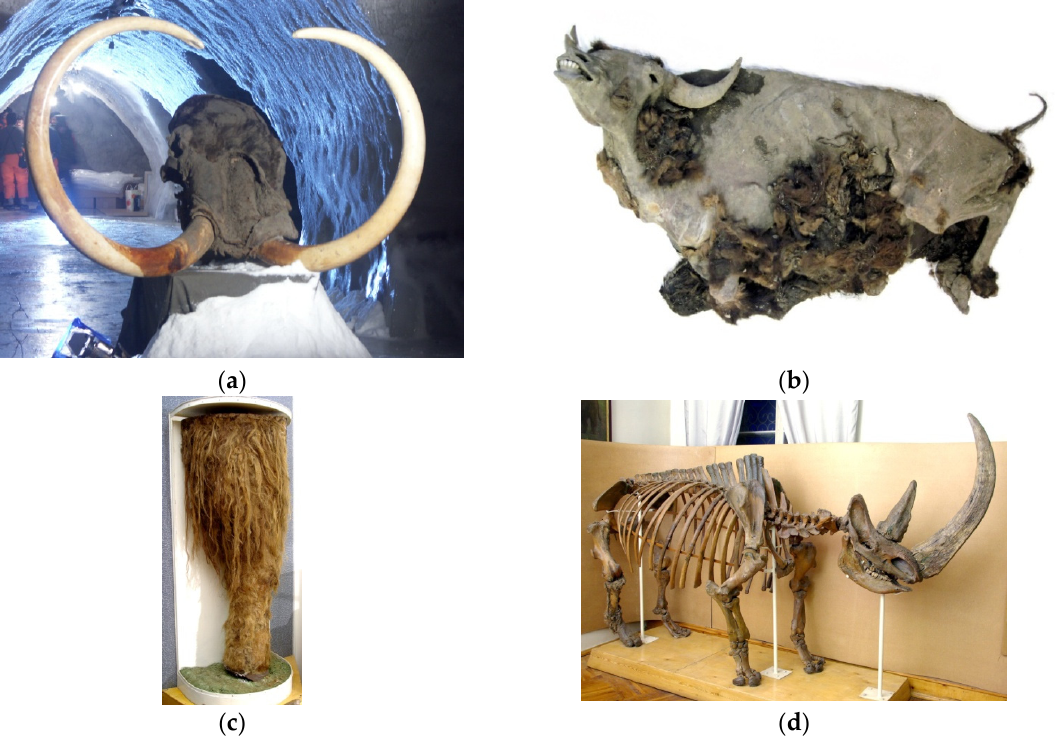
Figure 2. Photographs of the studied fossils of mammoth fauna mammals: ( a ) Yukagir mammoth head, ( b ) Yukagir bison, ( c ) posterior leg of Berelyokh mammoth, and ( d ) Churapcha rhino skeleton.